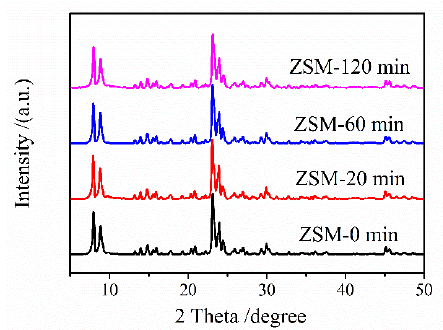
Figure 1. XRD patterns of ZSM-5 synthesized after evaporating ethanol for different times.